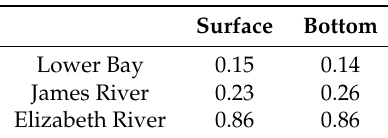
Figure 12. Comparisons between the baseline condition and the project scenario on the bottom/surface salinity along the thalweg of the Elizabeth River (with x = 0 at the river mouth). Table 1. Salinity increase (PSU; temporally and spatially averaged) in different regions under the project